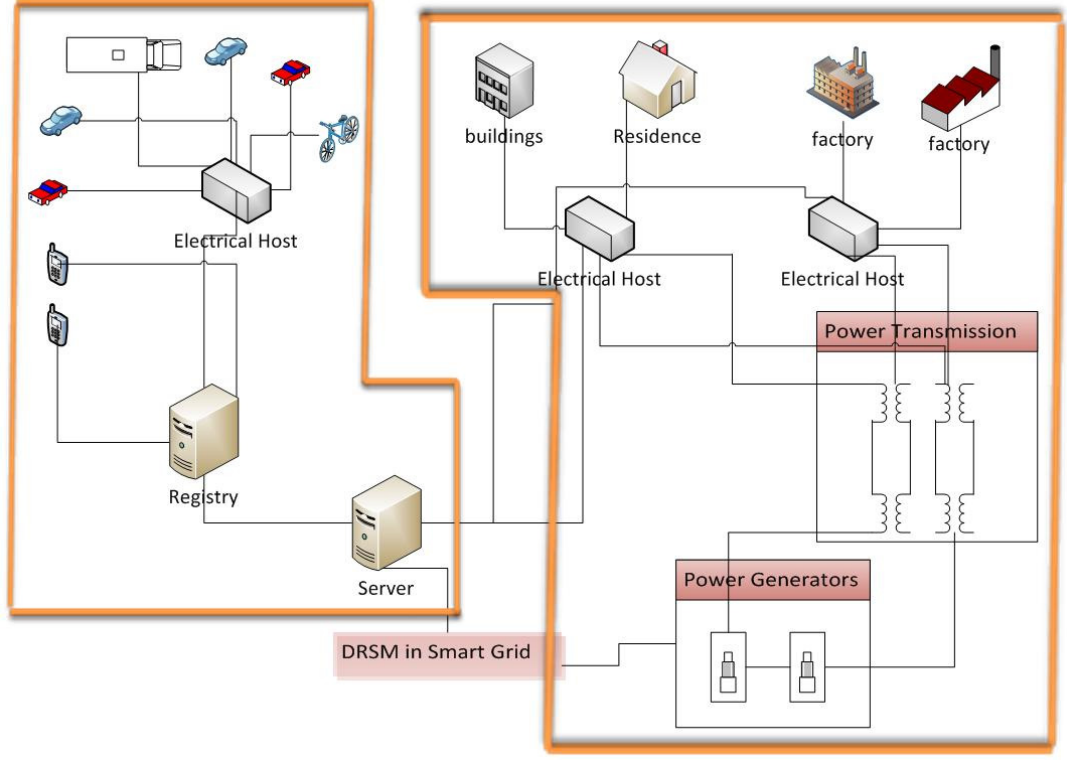
Figure 3. Whole structure of the smart grid